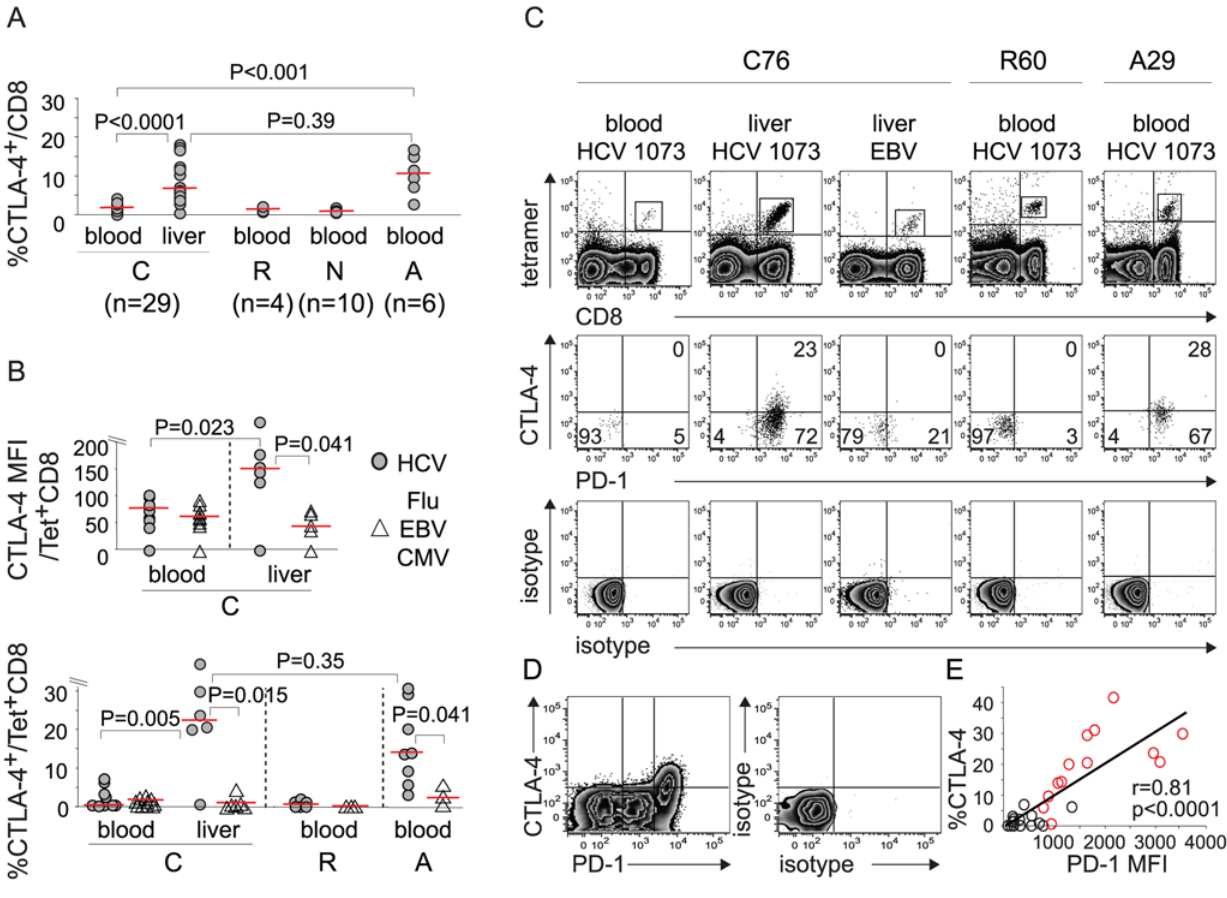
Figure 1. CTLA-4 expression is increased in intrahepatic HCV-specific CD8 T cells. (A) %CTLA-4 + in CD8 T cells from 29 chronic (C), 6 acute (A) and 4 resolved (R) hepatitis C patients and 10 HCV-seronegative controls (N). Median: C (blood 1.6%, liver 6.4%); R 1.3%; N 0.9%; A 10.6%. (B) CTLA-4 expression in tetramer + CD8 T cells specific for HLA-A2-restricted HCV (NS3 1073, NS3 1406, NS5 2594) and non-HCV (Flu, CMV and EBV) epitopes from 11C, 3R and 4A patients. Median CTLA-4 MFI: C (blood: HCV 77, non-HCV 61; liver: HCV 151, non-HCV 43). Median %CTLA-4 + : C (blood: HCV 1.4%, non-HCV 0.9%; liver: HCV 22.2%, non-HCV 0.6%); R (HCV 0.6%, non-HCV 0%); A (HCV 14.0%, non-HCV 2.9%). Red horizontal bars indicate median value. P-values were determined by Mann-Whitney U test. (C) Representative flow cytometry plots. (Top): Staining characteristics of tetramer + CD8 T cells. (Middle): PD-1/CTLA-4 staining of gated tetramer + CD8 T cells (dot plots). (Bottom): PD-1 and CTLA-4 cutoff strategy based on the isotype. (D) Representative FACS plots showing preferential CTLA-4 expression in PD-1-high cells (left) and cutoff strategy based on the isotype (left)